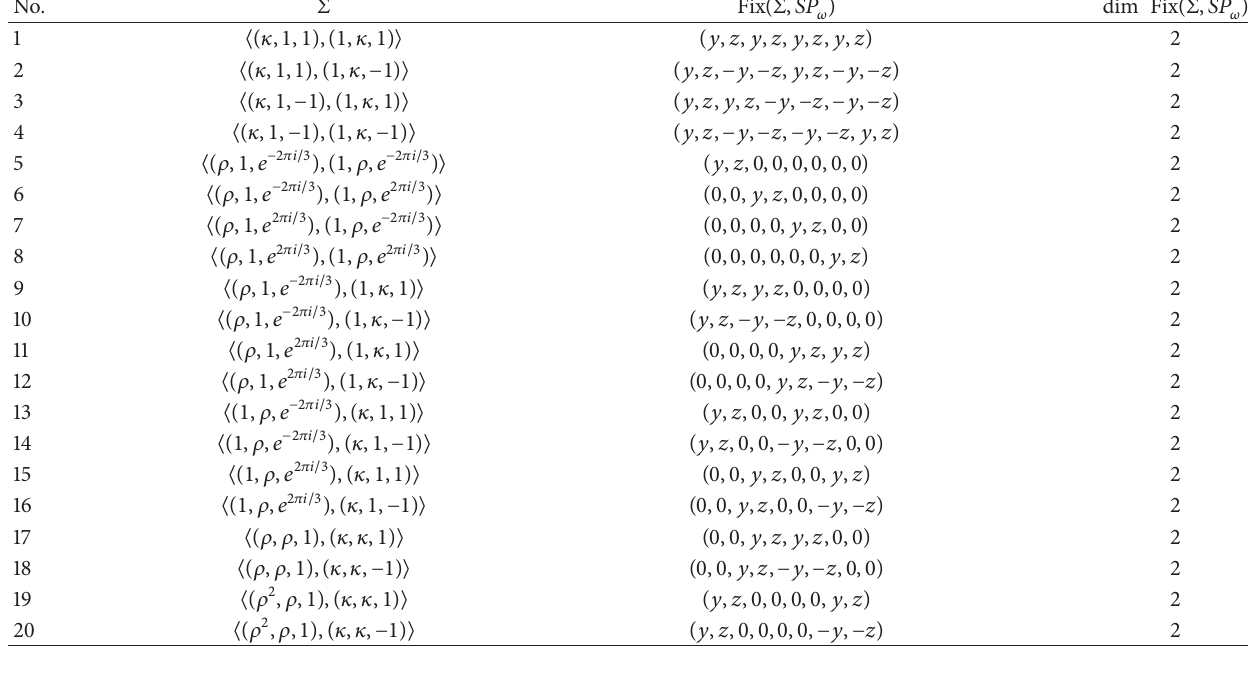
Table 1: The maximal isotropy subgroups of Γ × 𝑆 1 and associated fixed point subspaces. No. Σ Fix (Σ,𝑆𝑃 𝜔 ) dim Fix (Σ,𝑆𝑃 𝜔